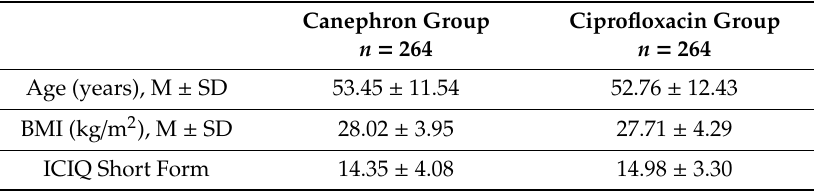
Table 1. Patients’ demographic data.